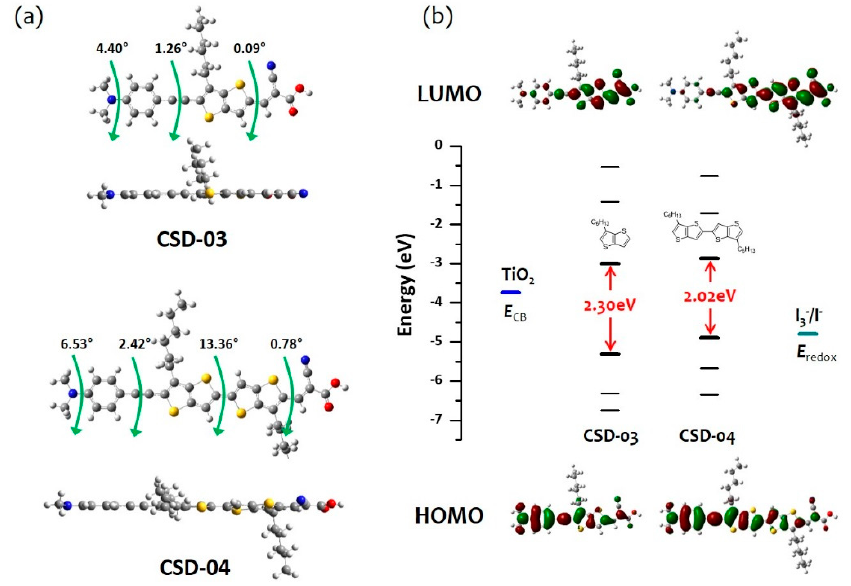
Figure 3. ( a ) Optimized geometries and ( b ) calculated electron distribution and energy levels of CSD- and CSD-04 03 and CSD-04 .